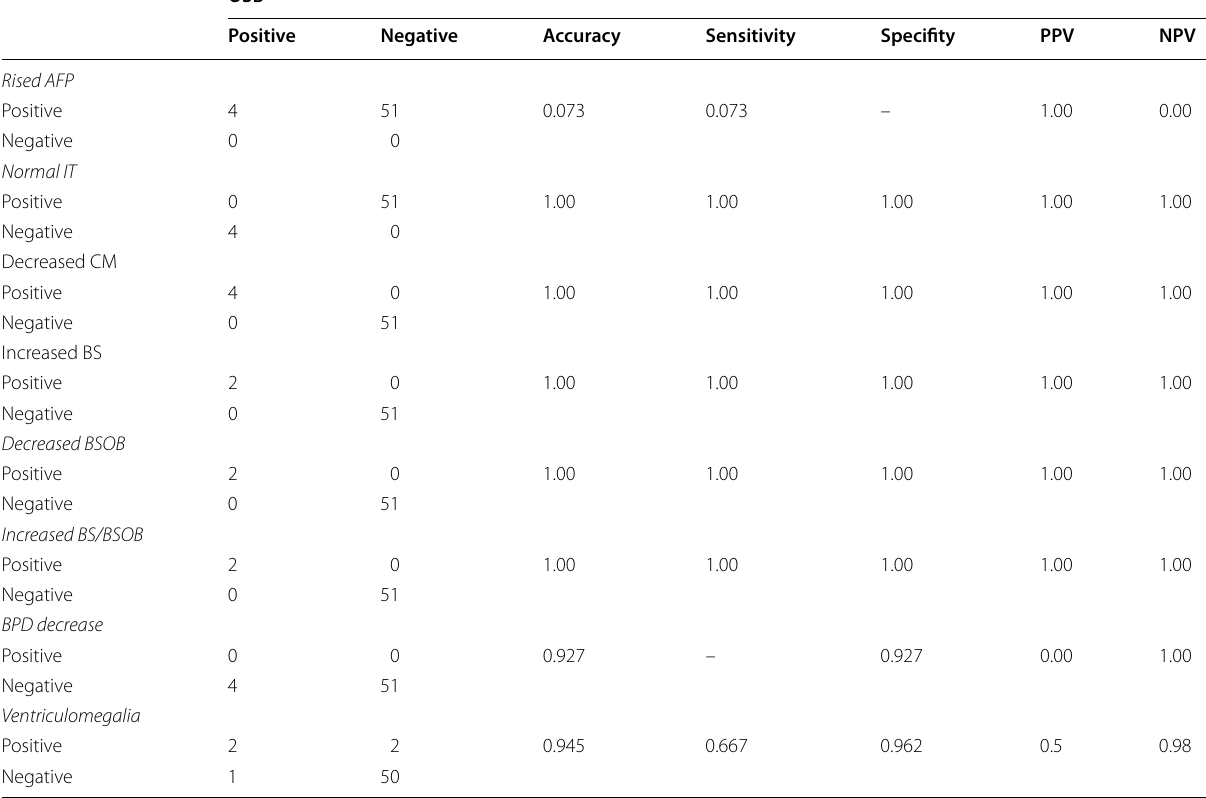
Table 3 Accuracy, sensitivity, specificity, PPV, NPV of sonographic parameters